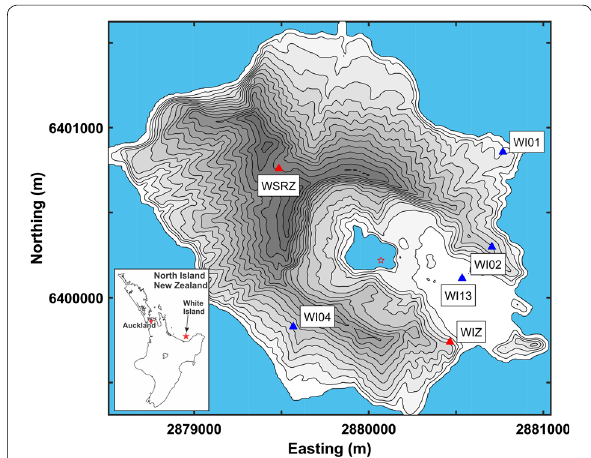
Fig. 1 Map of White Island showing permanent seismic and acoustic stations (red triangles) and portable seismic stations (blue triangles). The active vent for small mud/sulphur eruptions in 2013 are shown as a star within the central crater lake. Inset figure shows relation of White Island to the North Island, New Zealand. All distances are expressed in New Zealand Map Grid (NZMG)